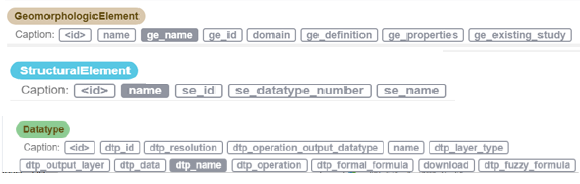
Figure 5: Properties of Geomorphologic Element, Structural Element and Datatype in the graph